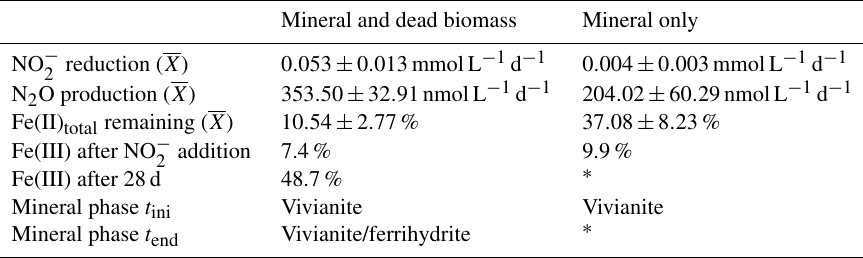
Table 1. Chemodenitrification kinetics and mineral transformation during the mineral and dead biomass and the mineral-only experiments. T ini values represent means calculated by summarizing results across all pH levels ± standard error. The overall respective reduction and production rates, given per day, were calculated as follows: [ C ] t values were calculated using 57 Fe Mössbauer spectroscopy data. Mineral phases were also identified using 57 Fe Mössbauer spectroscopy with spectra collected at 77K. The mineral-only sample taken after 28d was inadvertently destroyed prior to Mössbauer measurement.